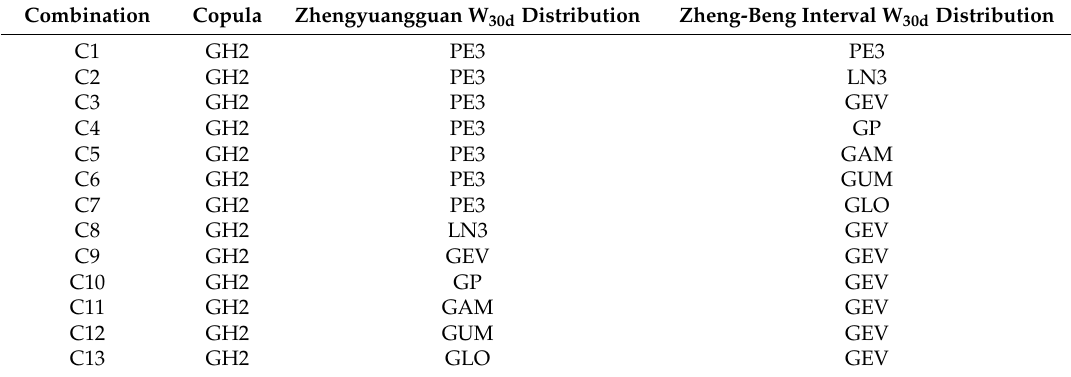
Table 5. Experimental design for CEC and CMLC point identification considering the uncertainty of marginal distribution selection.